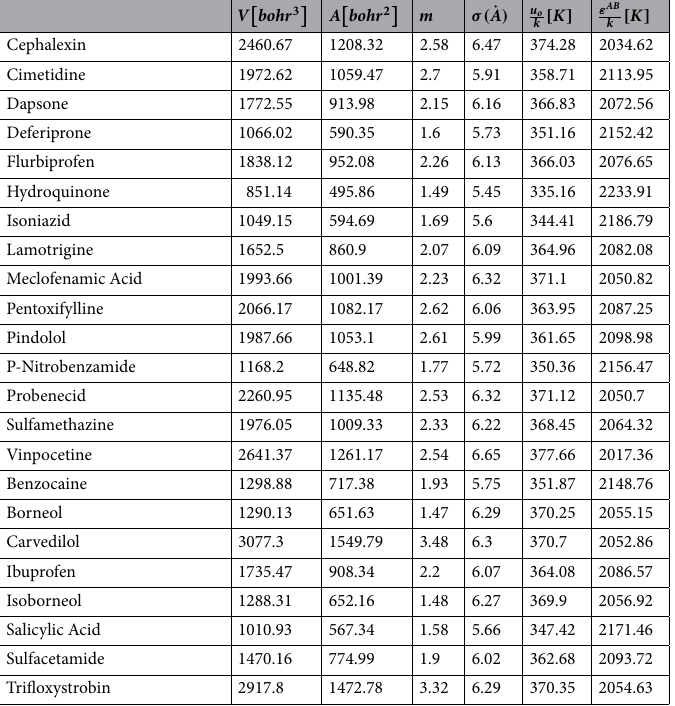
Table 2. COSMO file results and predictive PC-SAFT EOS